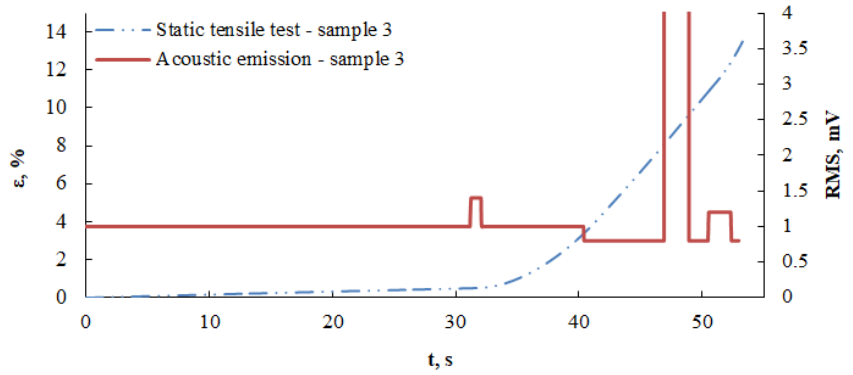
Figure 9. Diagram of RMS value and deformation as a function of time for Sample No. 3